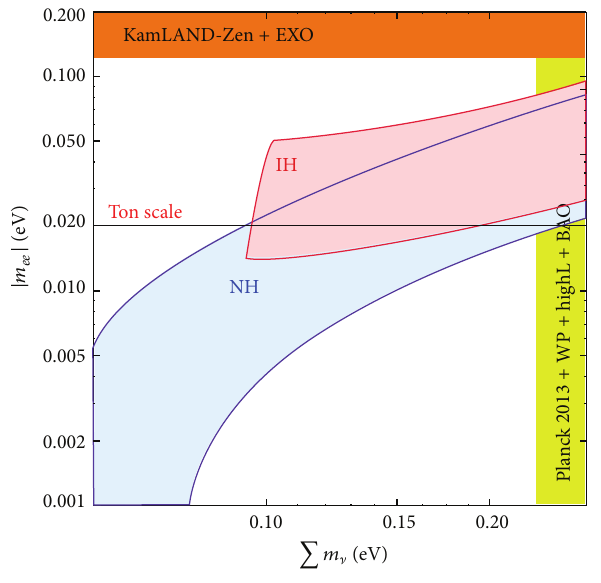
Figure 5: Sensitivity to the effective Majorana neutrino mass of the three xenon experiments as a function of the running time, assuming the parameters described in Table 1. We consider a run of 8 years for EXO-200 and KamLAND-Zen (2012 to 2020) and a run of 5 years for NEXT (2015 to